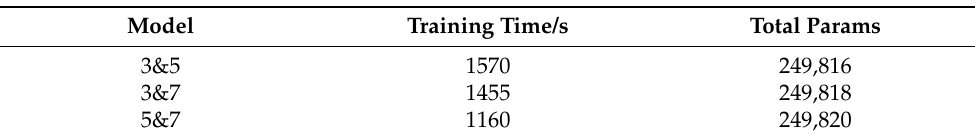
Table 1. Training time and number of parameters required for three different combinations of convolutional kernel sizes on the Pavia University